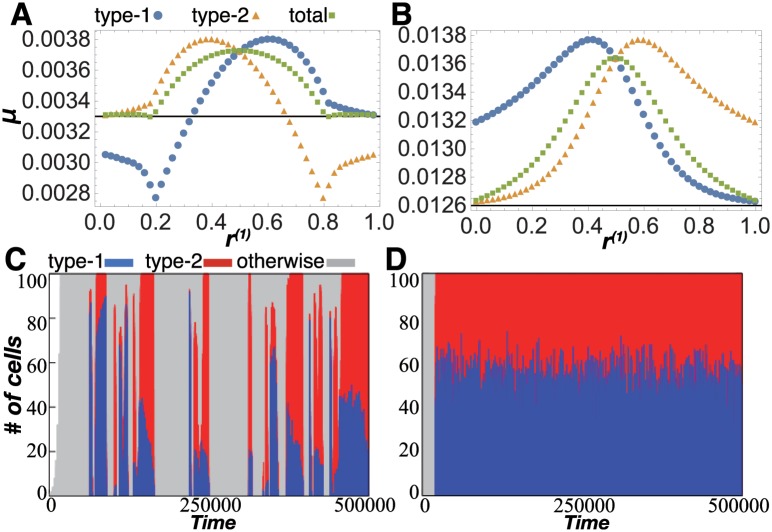
The stability of collective growth.(A) Network 1 in the r2cell model for (C, V, D) = (0.1, 1, 0.1), representing unstable collective growth. (B) Network 2 in the r2cell model for (C, V, D) = (0.15, 3, 1), representing balanced collective growth. In (A) and (B), the horizontal axis denotes the volume ratio of the two cells, r(1)≡v(1)/(v(1) + v(2)), and each black line displays the growth rate in the r1cell model μ(iso). Blue circles and orange triangles denote the growth rate of type-1 μ(1) and type-2 μ(2), respectively. Green rectangles indicate the total growth rate of the cell aggregate μ(tot)≡r(1)μ(1) + r(2)μ(2). (C) and (D) show the cell number distribution in the N-cell model (N = 100). Blue, red, and gray bars designate the numbers of type-1, type-2, and non-differentiated cells, respectively. (C) Case for network 1 with (C, Vmed, D) = (0.01, 100, 0.1). (D) Case for network 2 with (C, Vmed, D) = (0.3, 50, 0.1).